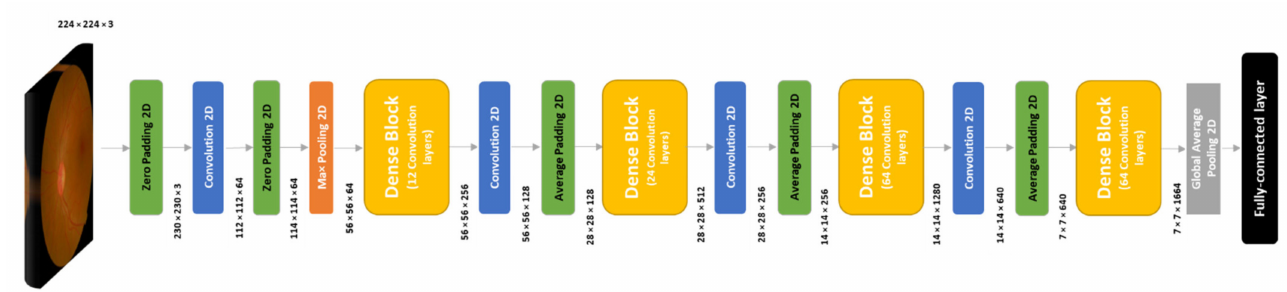
Figure 7. Architecture of DenseNet169